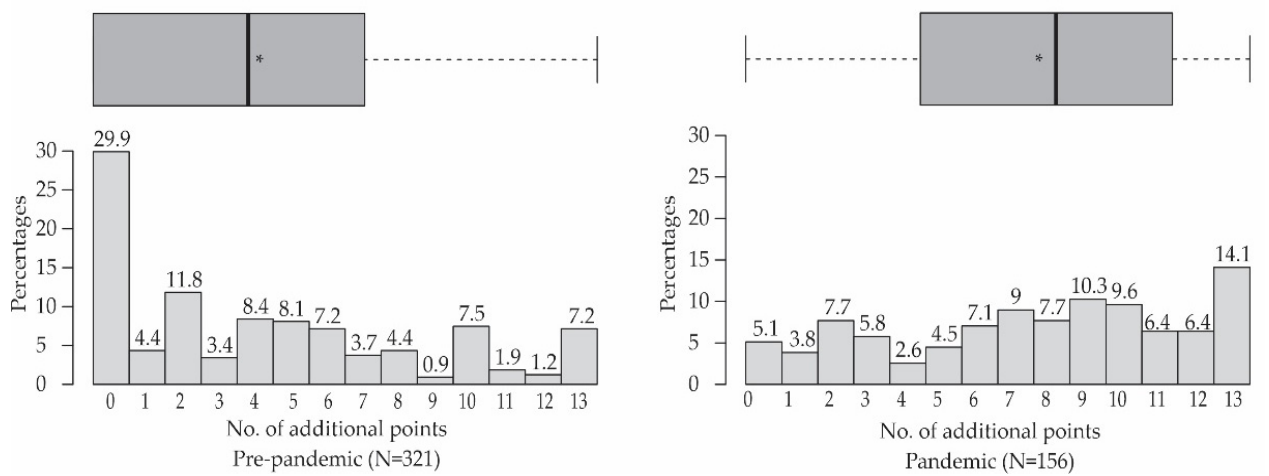
Figure 5. Histograms and boxplots for number of additional points in both groups of respondents, pre-pandemic ( left ) and pandemic ( right ). The asterisks (*) indicate average.